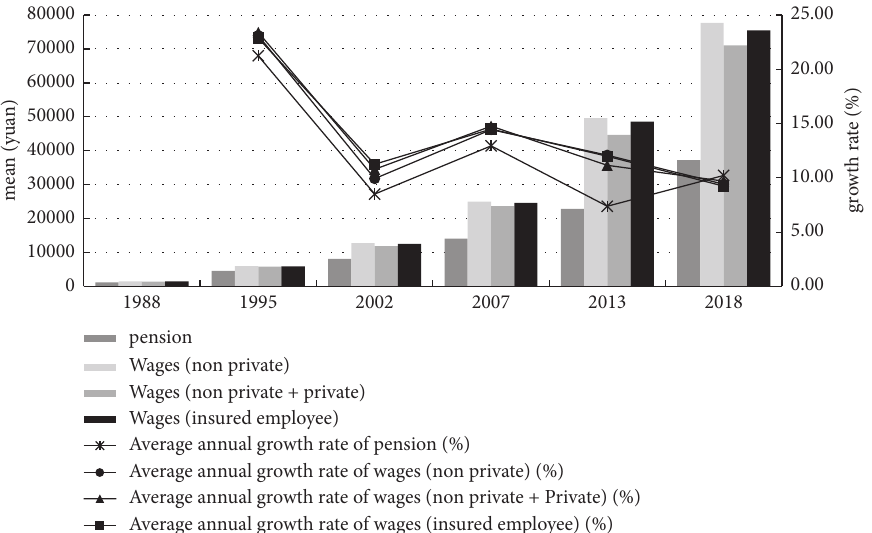
Figure 1: Average value and average annual growth rate of total pensions and total wages.